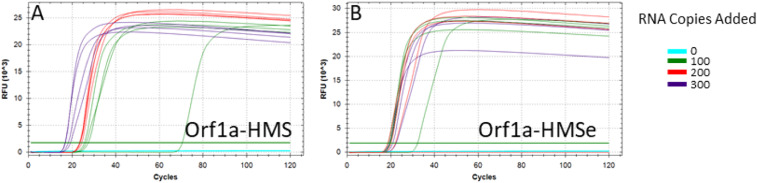
Initial sensitivity test of selected RT-LAMP primer sets. Fluorescent RT-LAMP reactions run for 120 30-s cycles at 65 °C: 0 (blue), 100 (green), 200 (red), or 300 (purple) control RNA copies included per reaction (n = 4). Assays performed were (A) Orf1a-HMS and (B) Orf1a-HMSe. RFU, relative fluorescence units.